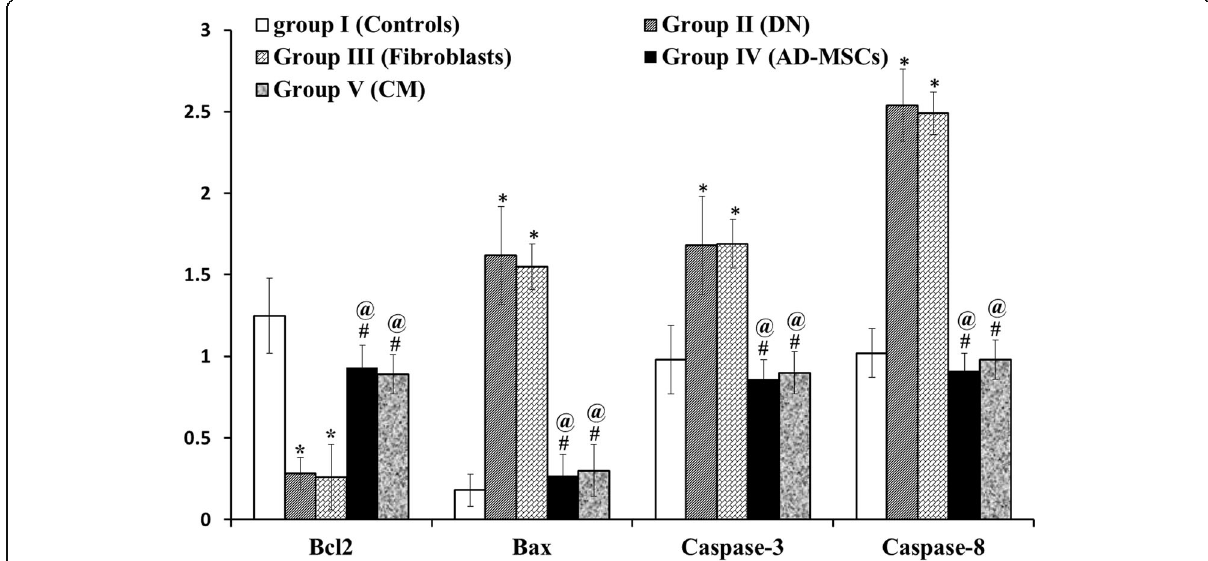
Fig. 2 mRNA gene expression of Bcl2, Bax, caspase-3, and caspase-8 when normalized to β -actin gene in group I (control), group II (DN), group III (fibroblast), group IV (AD-MSCs treated), and group V (CM). Asterisk (*) indicates high significant difference vs control group, number sign (#) indicates high significant difference vs DN group, and commercial at (@) indicates high significant difference vs fibroblast group ( P value < 0.001)